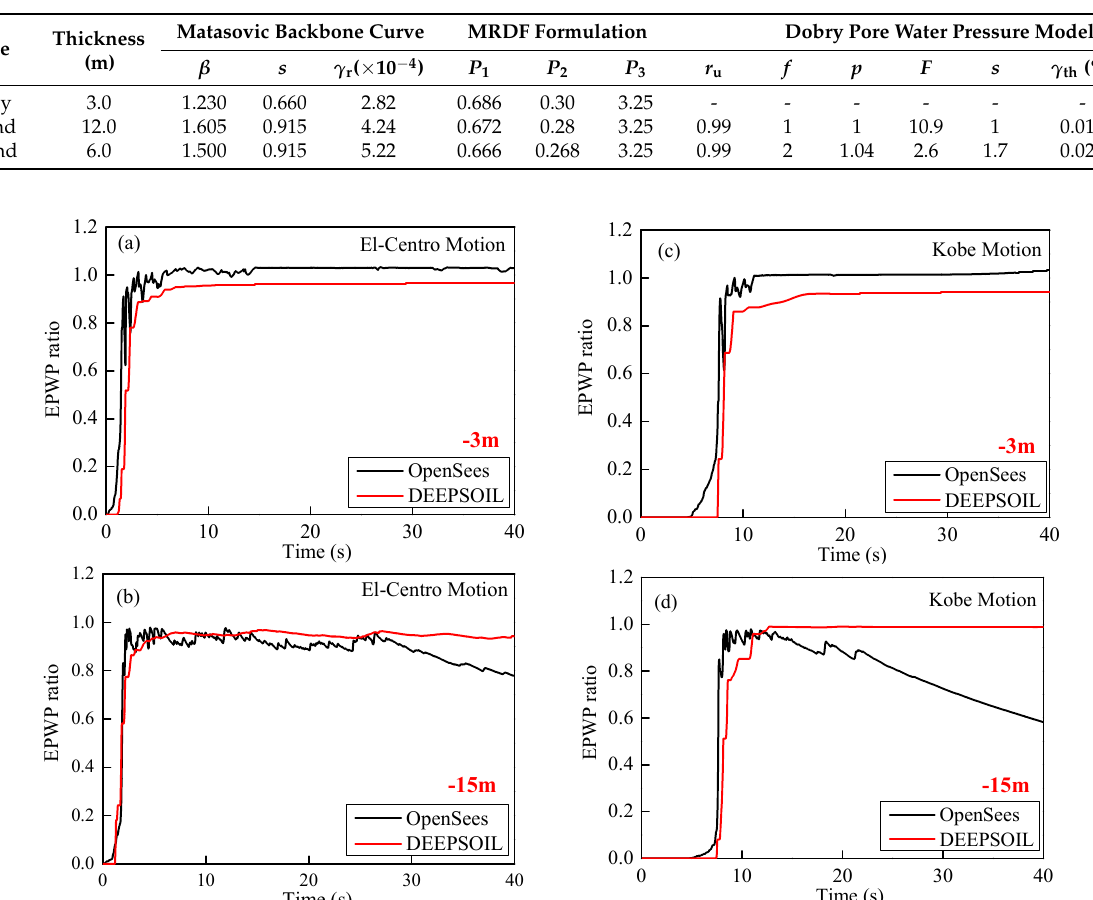
Table 4. Parameters of the Matasovic backbone curve, MRDF formulation, and the Dobry pore water pressure generation model.